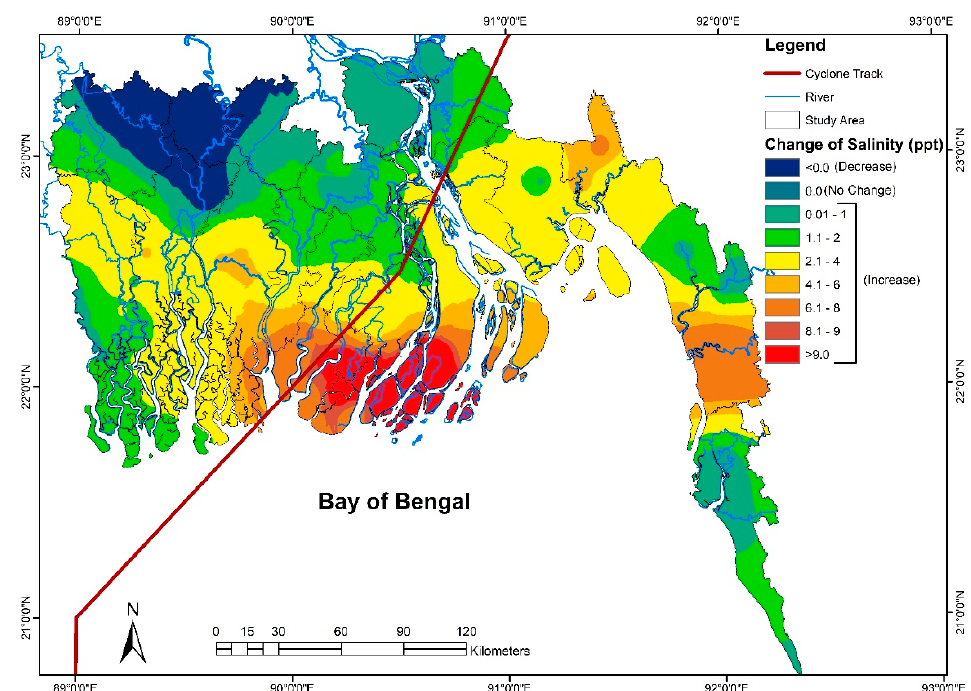
Figure 13. Change of salinity magnitude for an extremely severe climatic condition